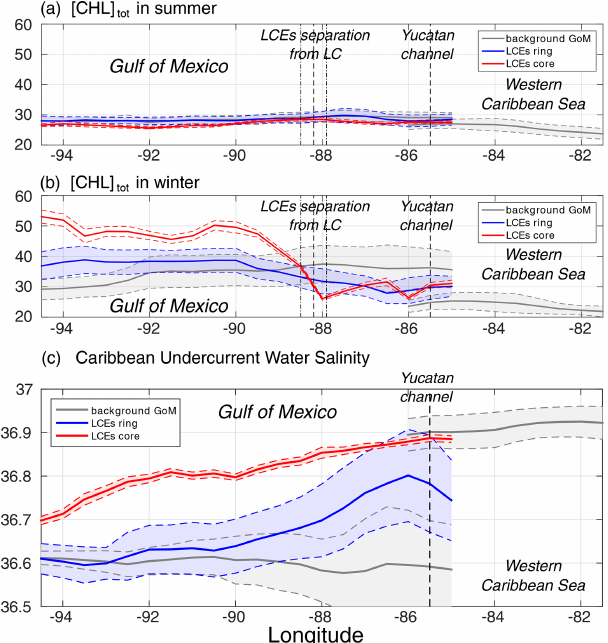
Figure 8. (a) Summer [Chl] tot , (b) winter [Chl] tot , and (c) salin- ity of Caribbean waters (ASTUW defined as the subsurface salinity maximum) as a function of longitude in (red) the LCE core, in (blue) the LCE ring, and in (gray) the background GoM. Full lines indi- cate the averaged value and dashed lines the ± 1 standard deviation